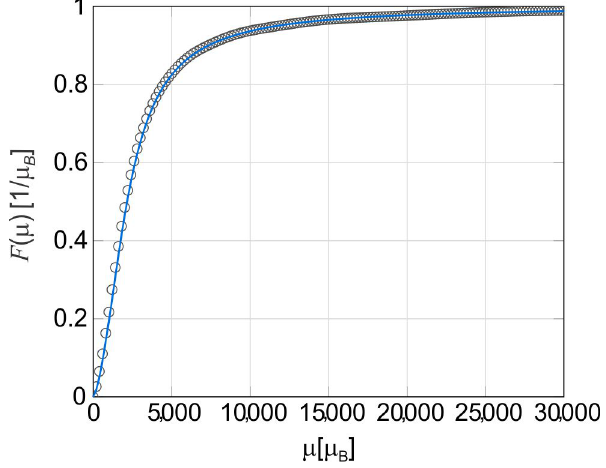
Figure 3. Representation of the cumulative distribution function F ( µ ) (continuous solid line) associ- ated to the probability density function f ( µ ), defined in Equation (15), and the step function F A , n ( µ ) with A = 10 5 µ B and n = 500, defined in Equation (11), which approximates to F ( µ ).